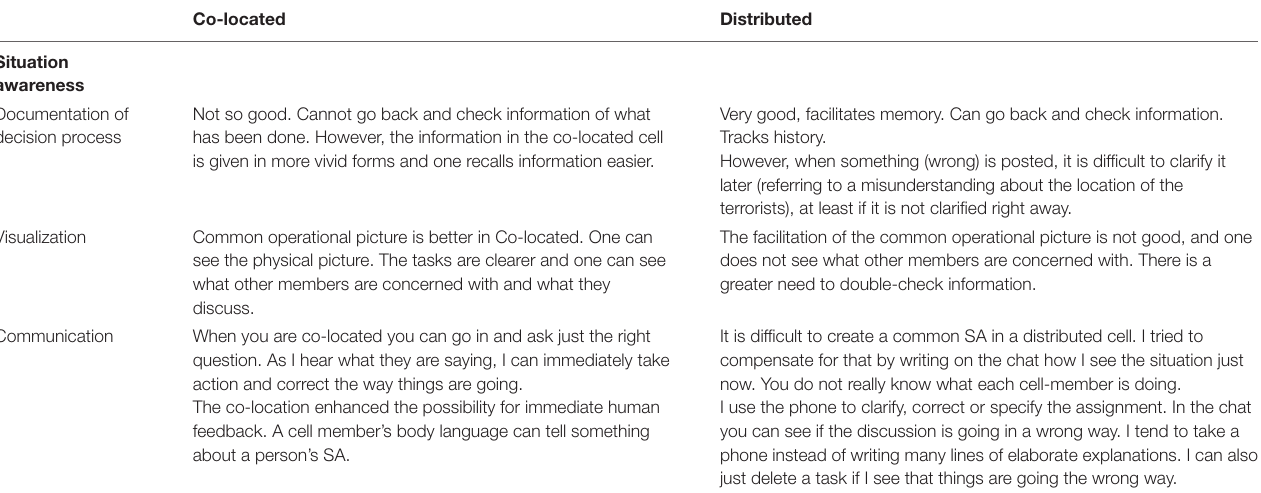
TABLE 2 | Summary interview with Cell-Chief. Co-located Distributed Situation awareness Documentation of decision